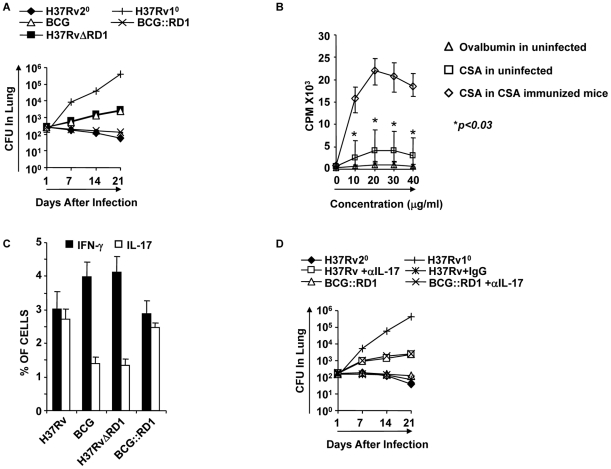
Clearance of H37Rv and BCG::RD1 induces improved protective immune responses compared with BCG and H37RvΔRD1.Animals were infected with the indicated bacterial strains for 30 days and treated with antibiotics for an additional 28 days. Animals were rested for one month and re-challenged with a low dose of H37Rv (∼110 bacilli) by aerosol challenge. Some groups were injected with anti-IL-17 antibodies (100 µg/mouse intravenous) or mouse IgG every 72 hrs until sacrifice at the time points indicated. (A) CFU in the lung homogenates of C57BL/6 mice that were previously infected with H37Rv, BCG, H37RvΔRD1 or BCG::RD1 strains. (B) Splenocytes were isolated from sixteen randomly selected animals from our colony or from CSA-immunized mice. Proliferation of splenocytes in response to CSA was measured by [3H]-thymidine incorporation assay. As a negative control, spleen cells were stimulated with OVA, and as a positive control, we measured the response against CSA by splenocytes from CSA-immunized mice. (C) Intracellular staining of CD4+ T lymphocytes in the lung of mice re-challenged with H37Rv. (D) CFU in lung homogenates of mice that received anti-IL-17 or control antibodies. Results presented in (A), (C) and (D) are representative of three independent experiments.